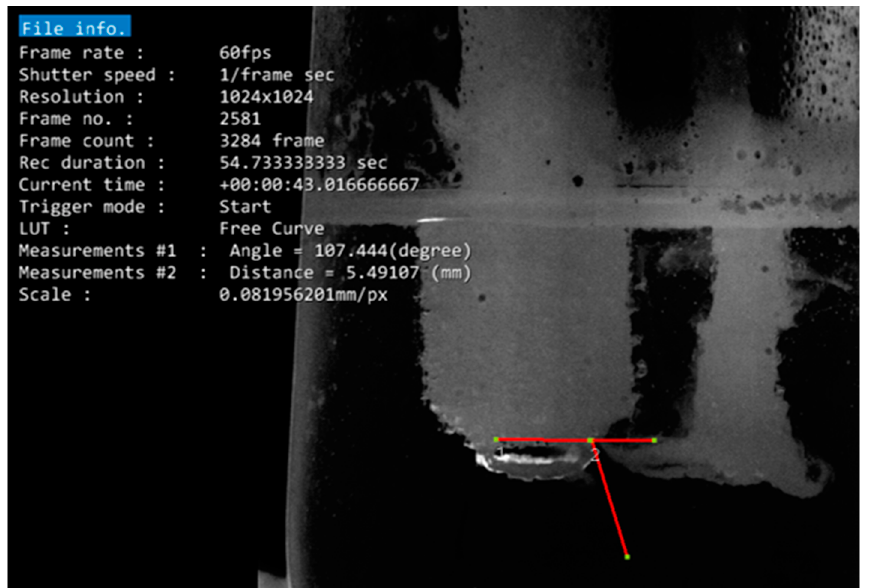
Figure A3. An example of measurement of wetting angle of the bubble on the horizontal anode just before it started to slide toward the edge of the anode to be detached during electrolysis at an average current density of 0.7 A cm − 2 .